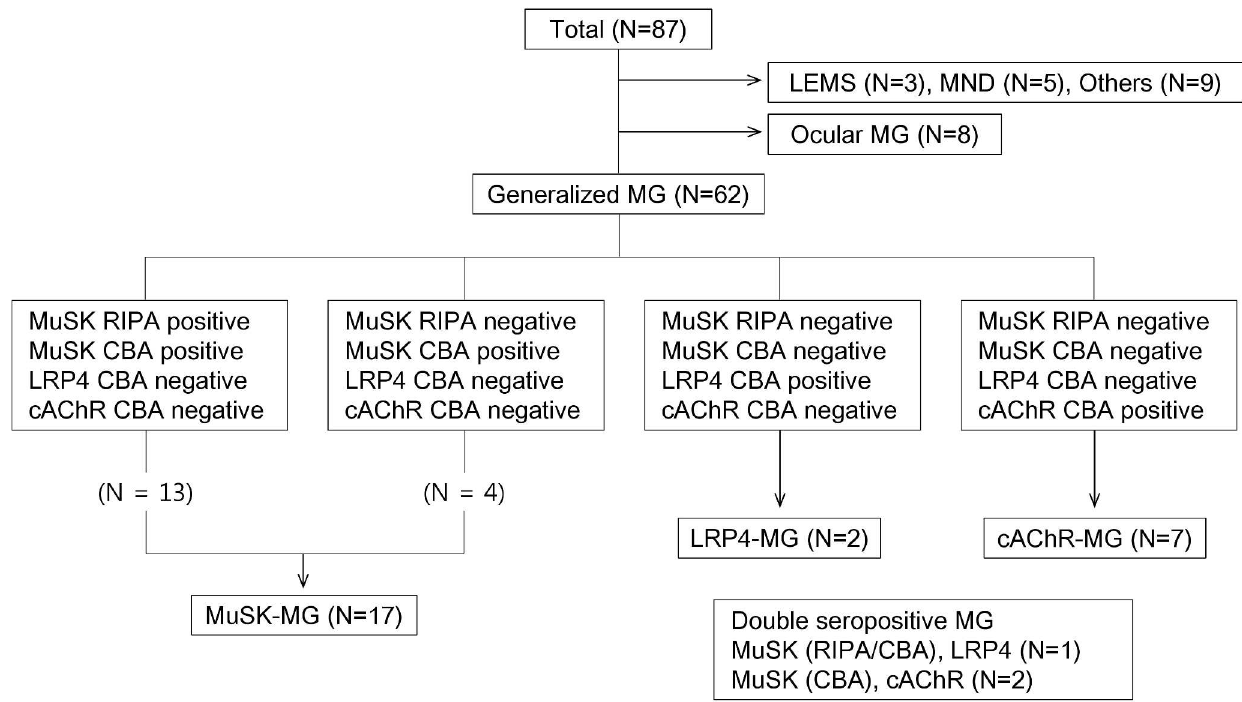
Fig 1. Antibody profiles for MuSK, LRP4, and clustered AChR in patients with MG seronegative for AChR antibody on radioimmunoprecipitation assay. LEMS, Lambert-Eaton myasthenic syndrome; MND, motor neuron disease; MG, myasthenia gravis; MuSK, muscle-specific tyrosine kinase; CBA, cell-based assay; RIPA, radioimmunoprecipitation assay; LRP4, low-density lipoprotein receptor-related protein 4; cAChR, clustered acetylcholine receptor.